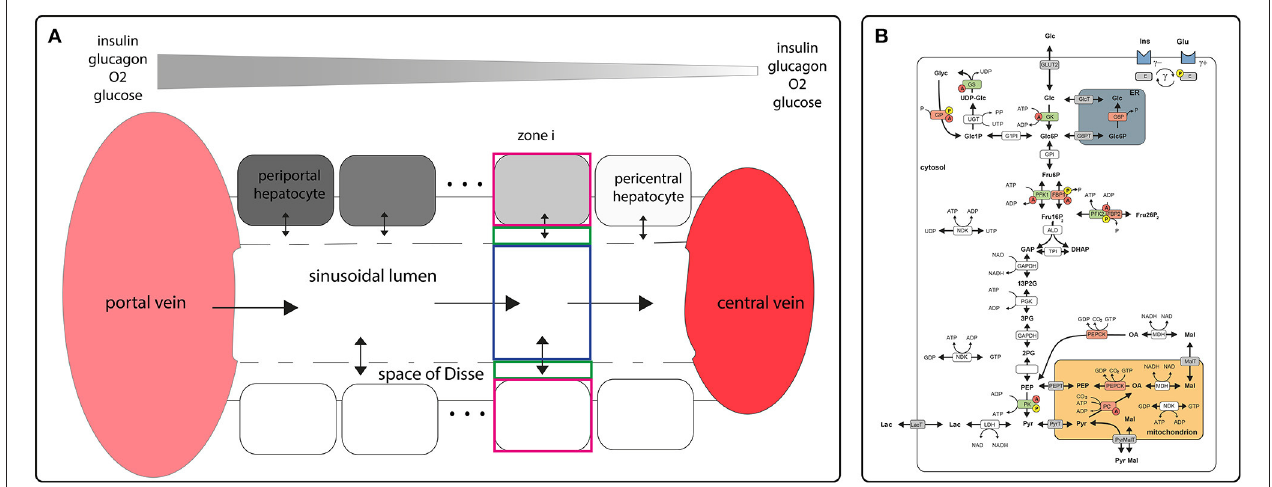
FIGURE 1 | Schematic model representation (A) sinusoidal blood flow model describing blood flow, nutrient and hormone distribution within the sinusoids. The model encompasses a single sinusoid, the adjacent space of Disse and the surrounding layer of hepatocytes. It is described by morphological parameters (blood vessel radius, thickness of the space of Disse, hepatocyte thickness, hepatocyte number, sinusoid length, degree of fenestration), and systemic parameters (central and portal vein hydrostatic pressure, plasma and lymph oncotic pressure, diffusion coefficients); (B) model of carbohydrate metabolism encompassing glycolysis, glyconeogenesis and glycogen synthesis and utilization. These pathways comprise the enzymes Glucokinase (GK), Glucose-6-phosphate isomerase (GPI), Phosphofructokinase 1 (PFK1), Aldolase (ALD), Triosephosphate isomerase (TPI), Glyceraldehydephosphate dehydrogenase (GAPDH), Phosphoglycerate kinase (PGK), Phosphoglycerate mutase (PGM), Enolase (EN), Pyruvate kinase (PK) Lactate dehydrogenase (LDH), Glucose-6-phosphate phosphatase (G6P), Phosphofructokinase 2 (PFK2), Fructose-2,6-bisphosphatase (FBP2), Fructose-1,6-bisphosphatase (FBP1), Phosphoenolpyruvate carboxykinase (PEPCK), Pyruvate carboxylase (PC), Nucleoside-diphosphate kinase (NDK), Malate dehydrogenase (MDH), Pyrophosphatase (PPASE), Glucose-1-phosphate isomerase (P1PI), Glycuronosyltransferase (UGT), Glycogen phosphorylase (GP), Glycogen synthase (GS) and transporters (ER < - > cytosol: Glucose-6-phosphate transporter (Glc6PT), Glucose transporter (GlcT); mitochondrion < - > cytosol: Pyruvate transporter (PYRT), Phosphoenolpyruvate transporter (PEPT), Malate transporter (MALT); extern < - > cytosol: Glucose transporter 2 (GLUT2), Lactate transporter (LACT). Enzymes that are phosphorylated or dephosphorylated in response to insulin (Ins) and glucagon (Glu) stimulus are marked by a yellow P, allosteric modification of enzymes is marked by a red A. The model contains the metabolites: glucose (Glc), glucose-6-phosphate (Glc6P), fructose-6-phosphate (Fru6P), fructose-1,6-bisphosphate (Fru16P 2 ), glyceraldehydephosphate (GraP), dihydroxyacetonephosphate (DHAP), 1,3-bisphosphoglycerate (13P2G), 3-phosphoglycerate (3PG), 2-phosphoglycerate (2PG), phosphoenolpyruvate (PEP), pyruvate (Pyr), lactate (Lac), malate (Mal), oxaloacetate (OA), glucose-1-phosphate (Glc1P), UDP-glucose (UDP-glc), glycogen, fructose-2,6-bisphosphate (Fru26P 2 ). The cofactors NADH, NAD, ATP, ADP, UTP and UDP are not treated as dynamic variables. All physiological metabolites produced or consumed in the hepatocyte during glycolysis and gluconeogenesis are comprised into lactate. Figures adapted from Berndt et al. (2018).